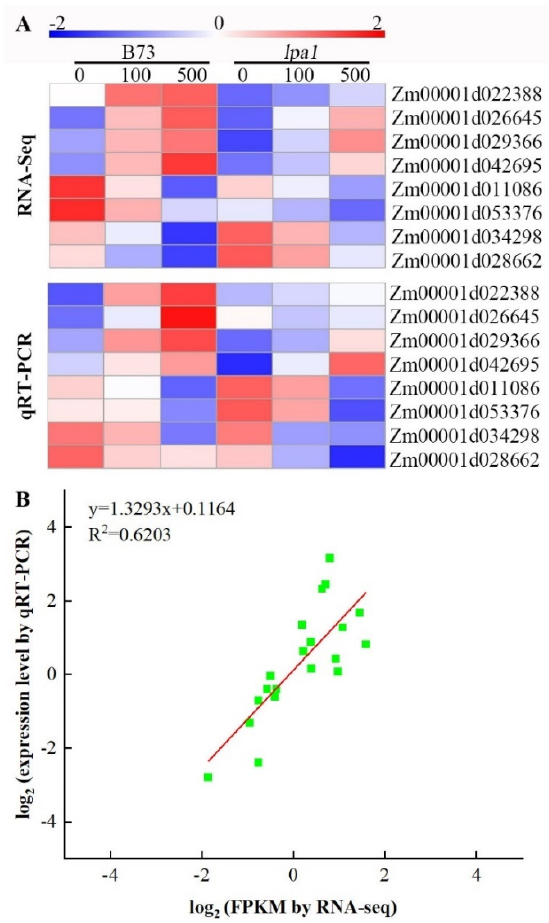
Figure 9. The expression pattern of eight selected genes identified by RNA-seq was verified by qRT-PCR. ( A ) Heat map showing the expression changes (log 2 fold change) in response to the B73-CK to lpa1 -500 treatments for each candidate gene as measured by RNA-seq and qRT-PCR; ( B ) Scatter plot showing the changes in the expression (log-fold change) of selected genes based on RNA-seq via qRT-PCR. The gene expression levels are indicated by colored bars.